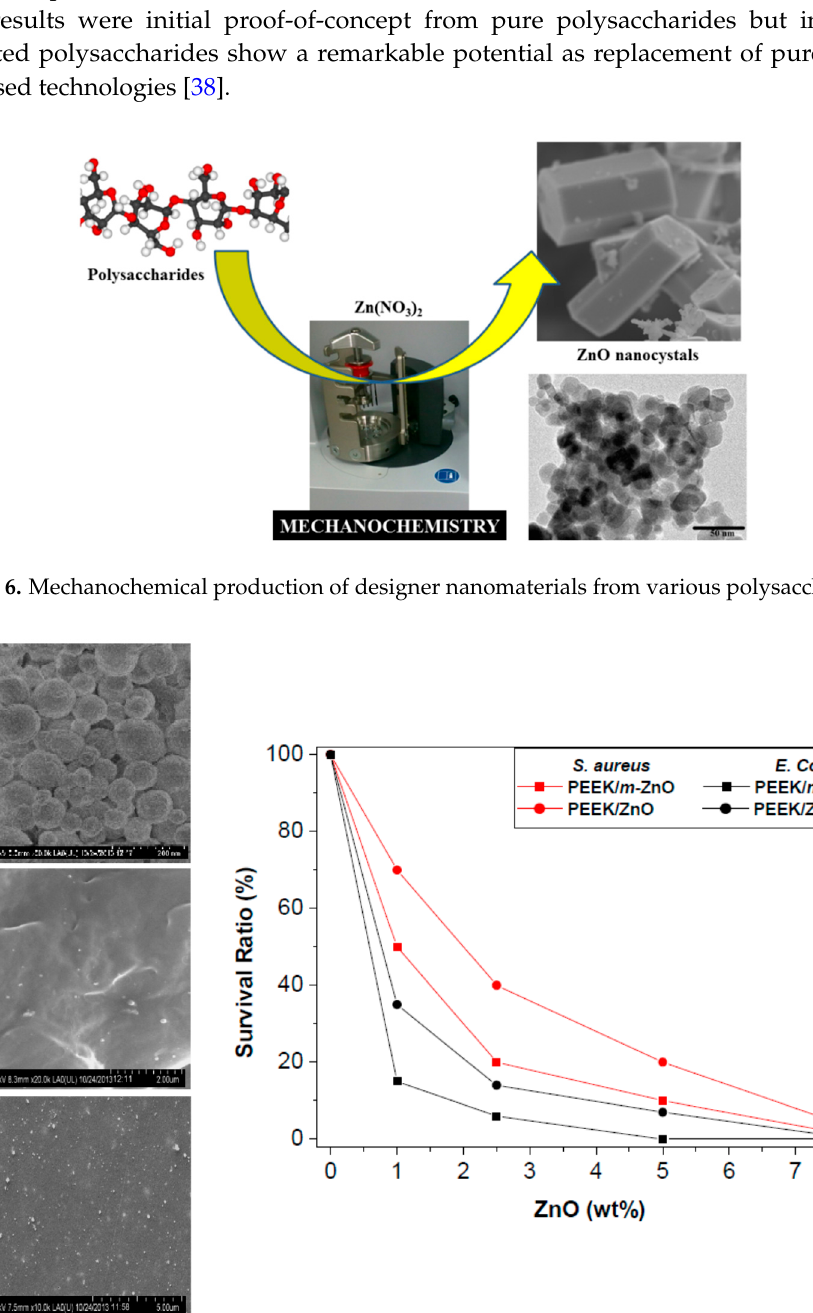
Figure 7. SEM of synthesized novel poly(ether ether ketone)/ZnO nanocomposites ( b , d , f images ) with biotemplated ZnO for antimicrobial applications for S. aureus and E. Coli . Reproduced by permission of the Royal Society of Chemistry from Reference [39].